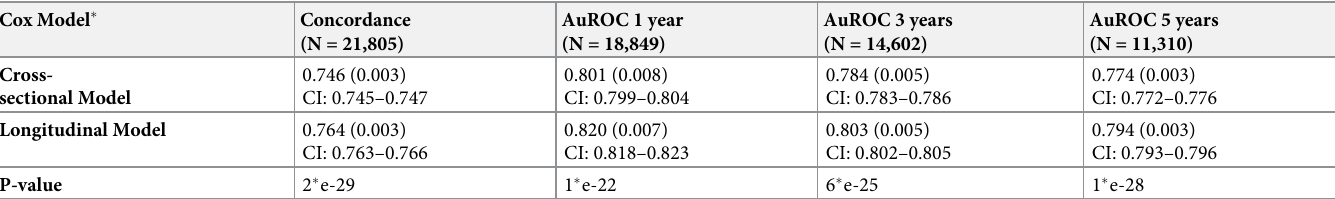
Table 2. Performance of Cox models.